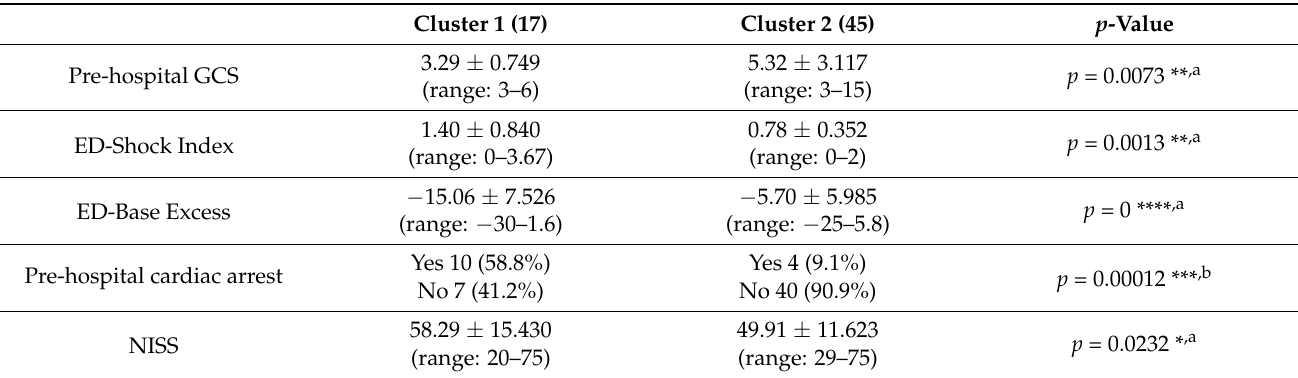
Figure 4. Cluster analysis of trauma-related variables in DBD. Each number matches one donor, and marked with Yes or No according to whether they were managed with DCS or not. The analysis reaches to divide the population into two clusters according to the variables described in the materials and methods section. Table 2. Variables related to the clinical condition of major trauma patients in the prehospital setting and Emergency Department (ED). Differences between clusters. The complete results of this analysis are shown in Appendix A.